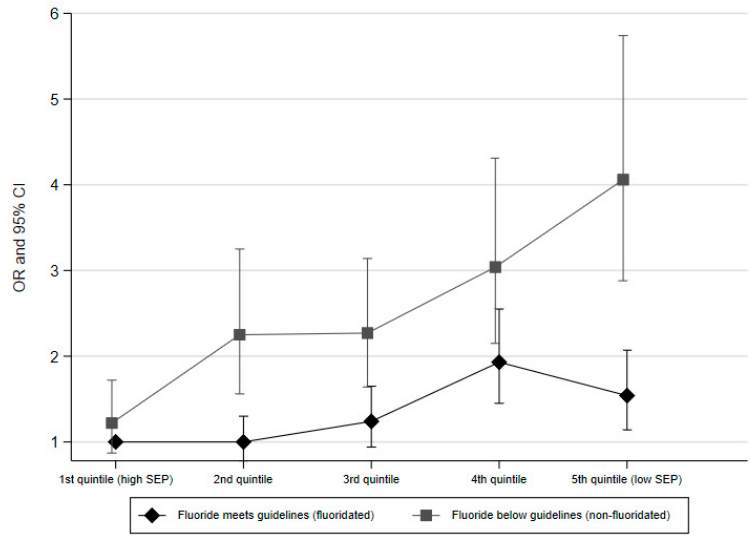
Figure 3. The odds ratio and 95% confidence intervals for each SEP quintile for those who live in fluoridated or non-fluoridated areas.